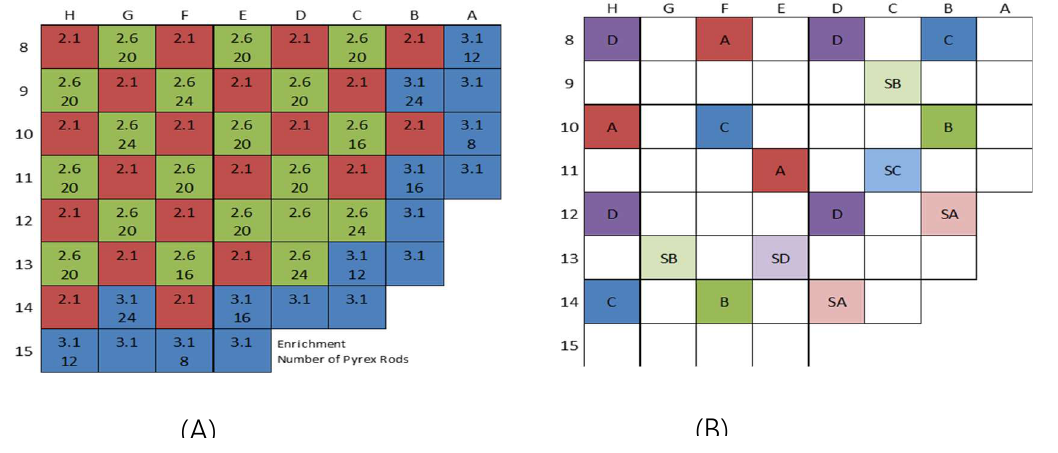
Figure 1. Assembly, Poison (A) and Control Rod Layout (B) – ¼ Symmetry.